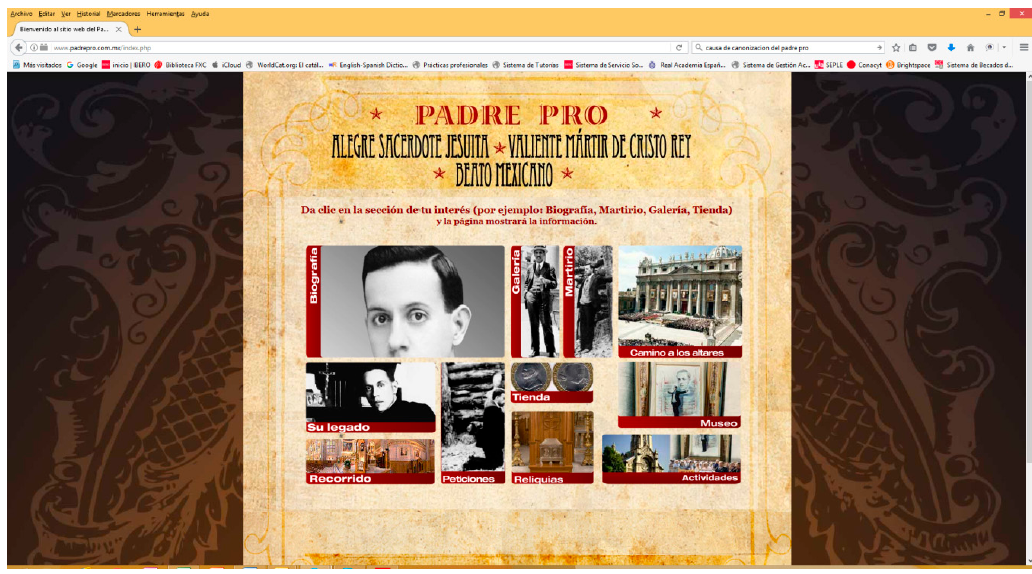
Figure 3. Main page of padre Pro´s official website. Screenshot taken on March 2019.